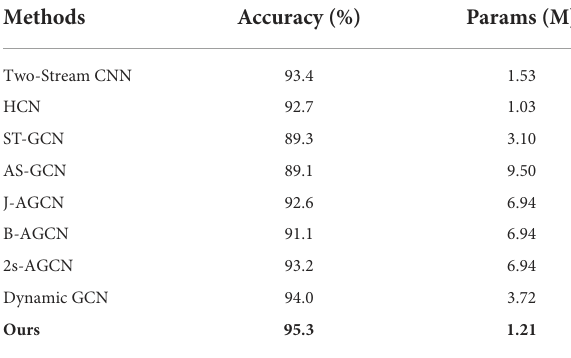
TABLE 1 Comparison of different algorithms on Filtered NTU RGB+D